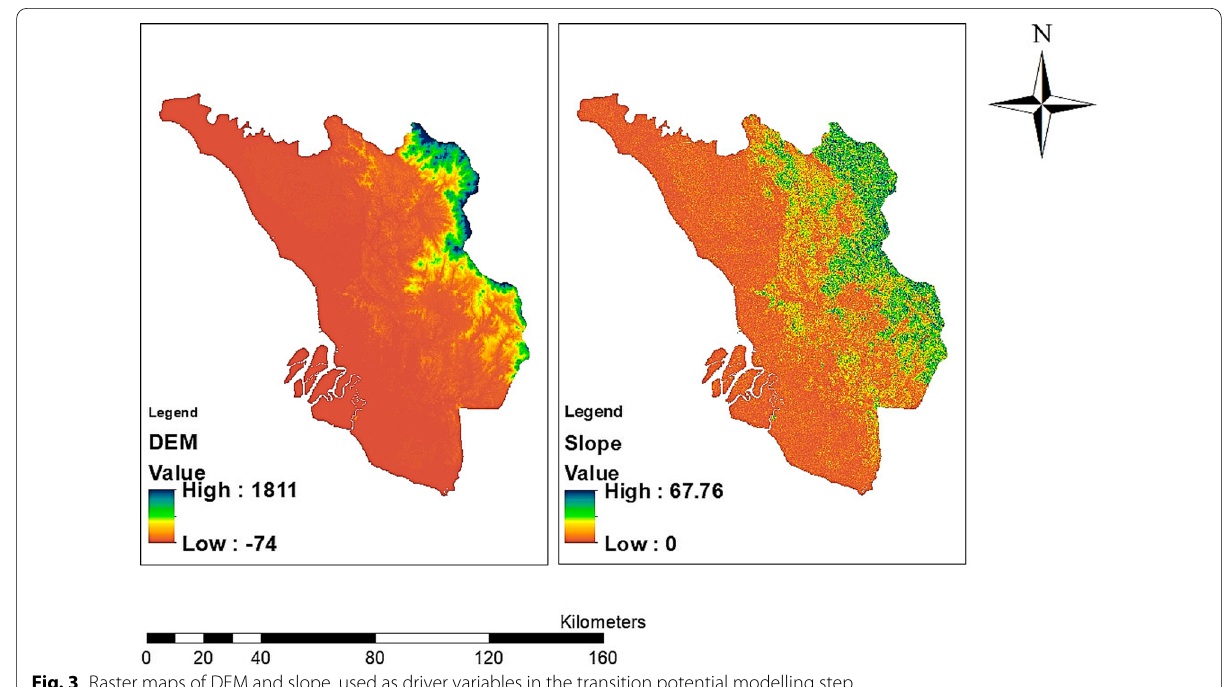
Fig. 3 Raster maps of DEM and slope, used as driver variables in the transition potential modelling step